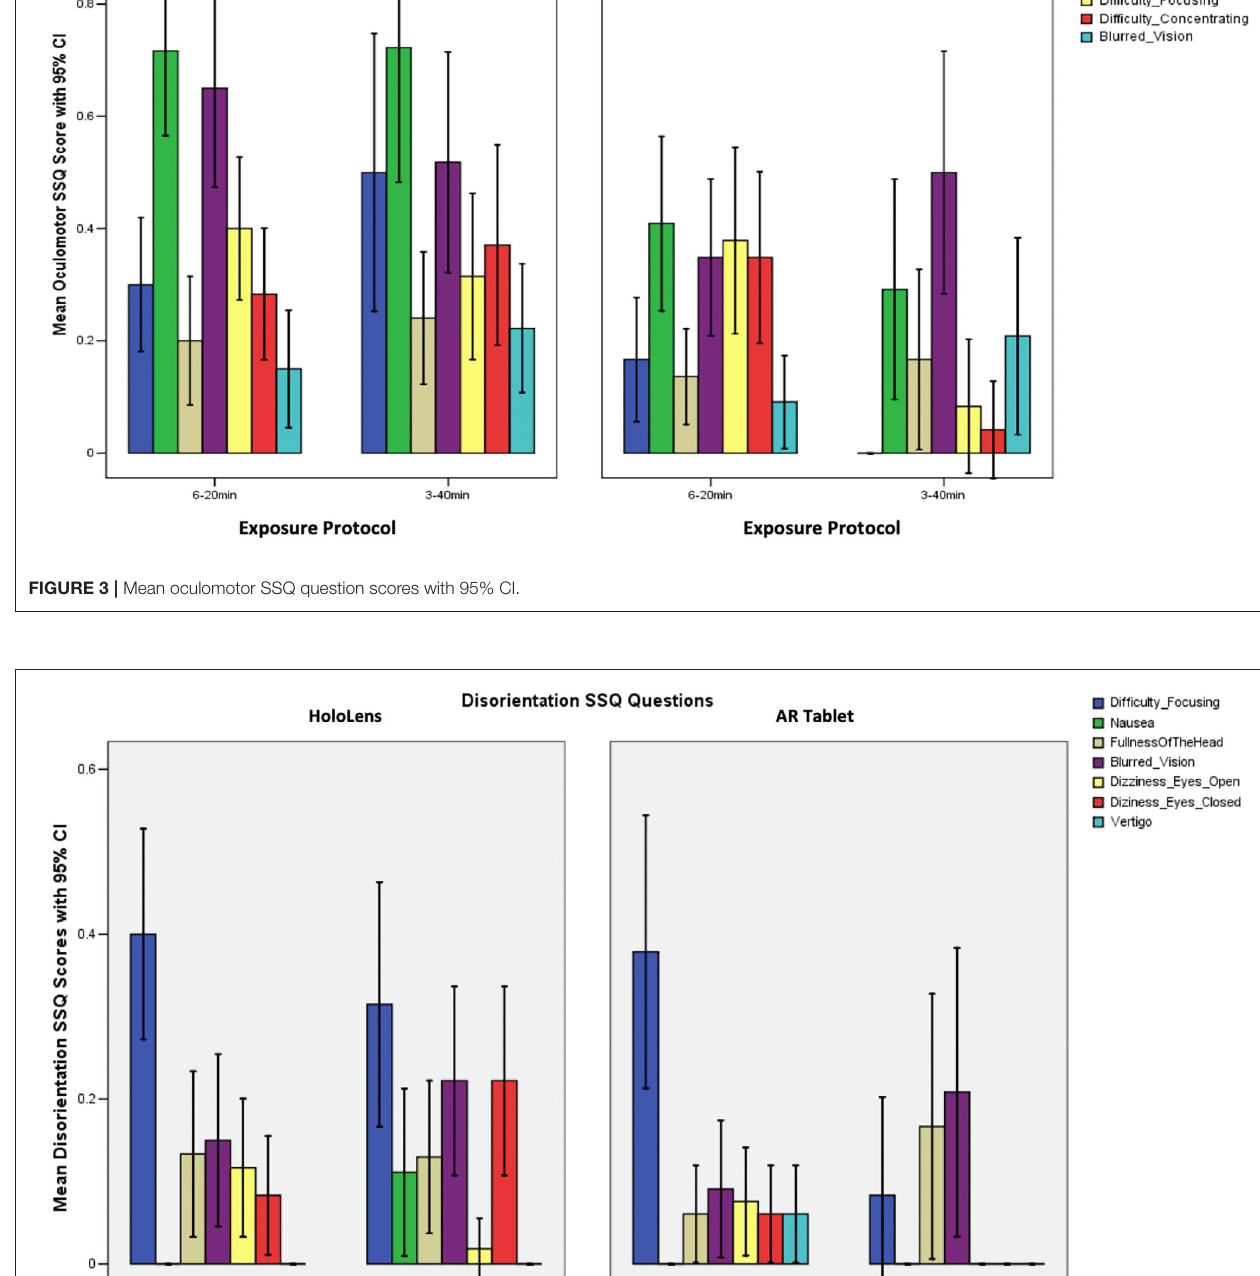
Frontiers in Virtual Reality | www.frontiersin.org